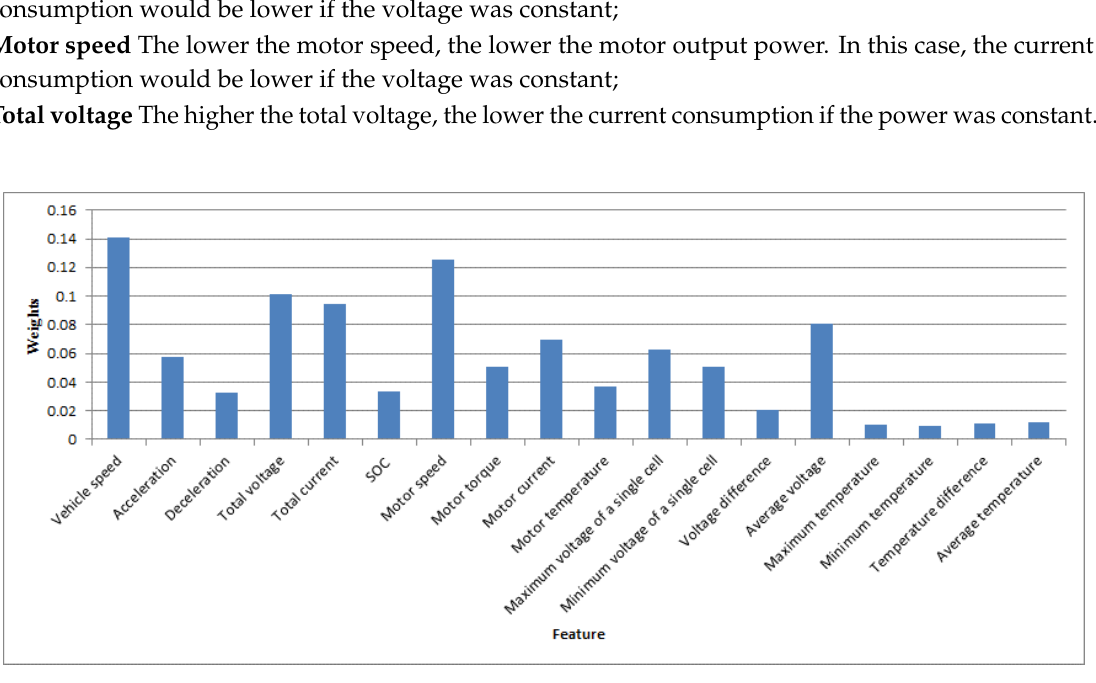
Table 7. Classification rules of the optimal decision tree model.